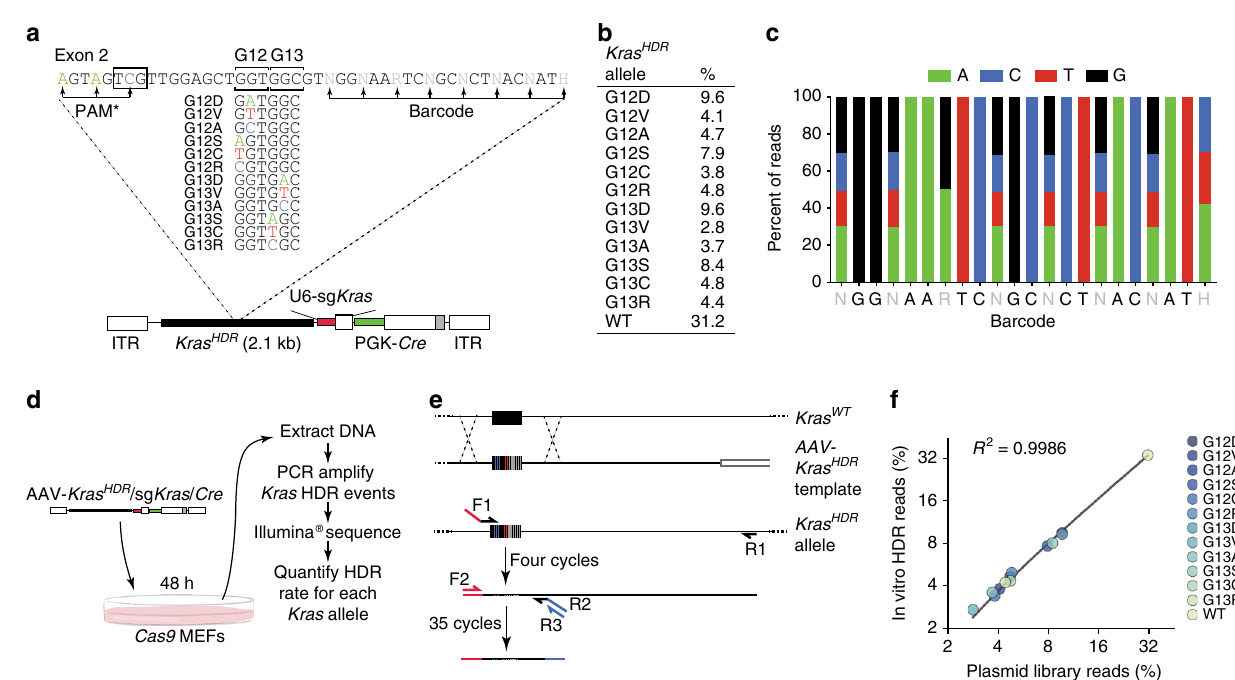
Fig. 2 Design and validation of an AAV targeting vector library to introduce all Kras codon 12 and 13 single-nucleotide non-synonymous point mutations into somatic mouse cells in a multiplexed manner. a AAV vector pool for Cas9-mediated HDR into the endogenous Kras locus (AAV- Kras HDR /sg Kras / Cre ). Each vector contained an HDR template with 1 of 12 non-synonymous Kras mutations at codons 12 and 13 (or wild-type Kras ), silent mutations within the PAM (boxed sequence) and sgRNA homology region (PAM*), and a random 8-nucleotide barcode within the wobble positions of the adjacent codons for stable DNA barcoding of individual tumors. b Representation of each Kras HDR allele in the AAV- Kras HDR /sg Kras / Cre plasmid library. c Diversity of the barcode region in the AAV- Kras HDR /sg Kras / Cre plasmid library. d Schematic of the experiment to test for HDR bias. A Cas9-expressing cell line was transduced with AAV- Kras HDR /sg Kras / Cre and Kras HDR alleles were sequenced to quantify HDR events. e Schematic of the PCR strategy to speci fi cally amplify Kras HDR alleles introduced into the genome via HDR. Forward primer 1 (F1) binds to the sequence containing the 3 PAM* mutations, while reverse primer 1 (R1) binds the endogenous Kras locus, outside the sequence present in the homology arm of the Kras HDR template. F2 binds to the Illumina adaptor added by F1, R2 binds to a region near exon 2, and R3 binds to the Illumina adapter added in the same reaction by R2. f Frequency of HDR events for each Kras HDR allele plotted against the initial frequency of each Kras mutant allele in the AAV- Kras HDR /sg Kras / Cre plasmid library. High correlation between the initial plasmid library and the representation of mutant Kras alleles following HDR suggests little to no HDR